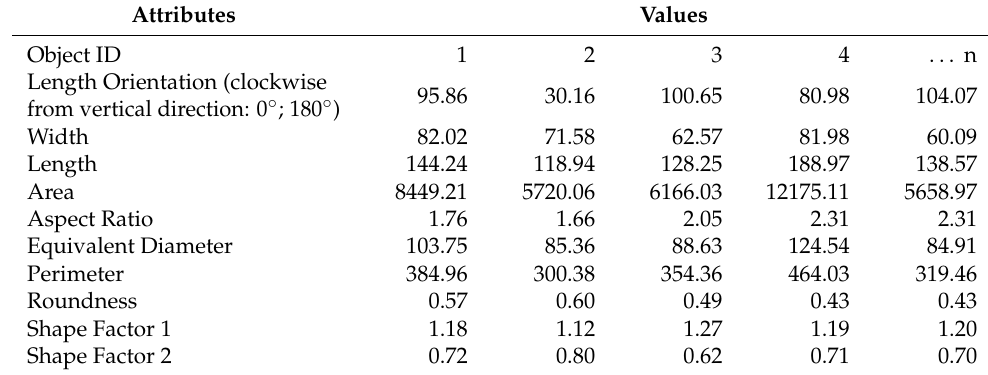
Table 2. Example of the dataset of grain size descriptors and shape factors derived from the GSD